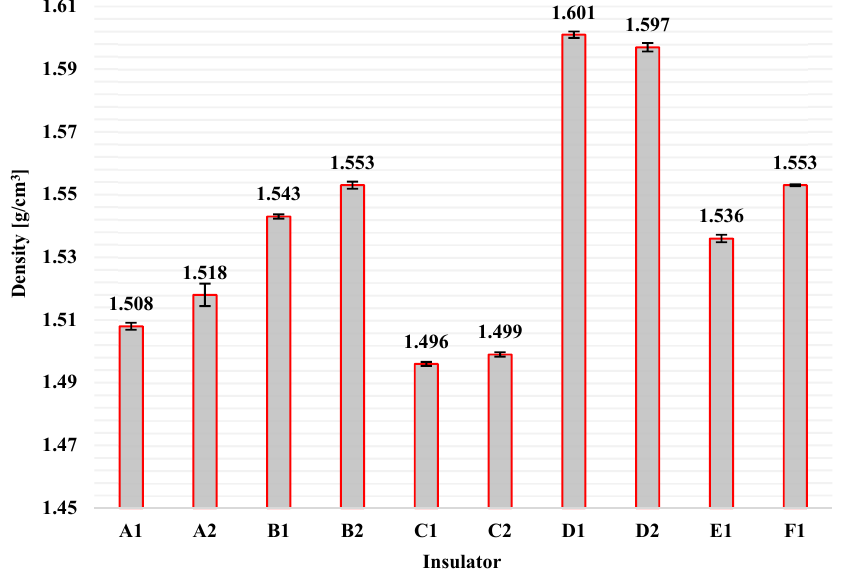
Figure 11. Average values of density measurements (columns) and the corresponding standard deviations (error bars) for the HTV silicone rubber with ATH filler material of all available composite insulators.